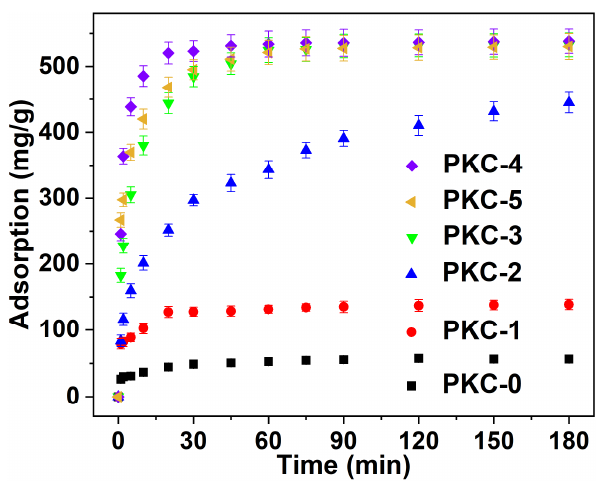
Figure 4. Time-dependent adsorption capacities over different biochars.